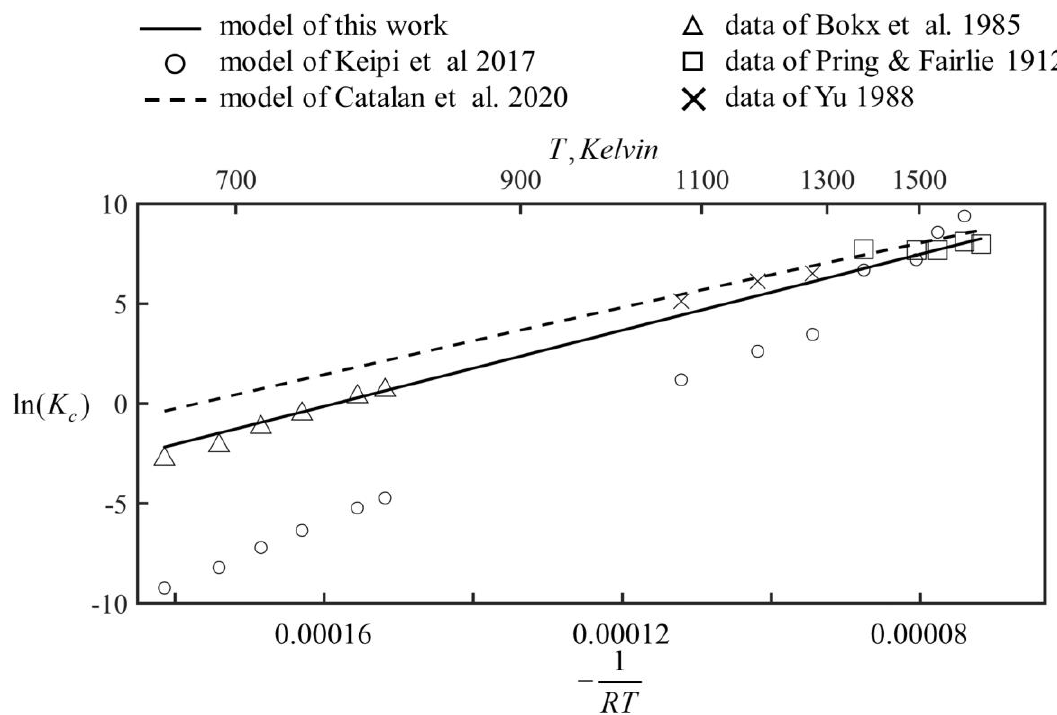
Figure 4. An Arrhenius plot of reaction equilibrium constant K c predictions from reversible methane cracking kinetic models compared to published equilibrium data from experiments [28–30,55,56].